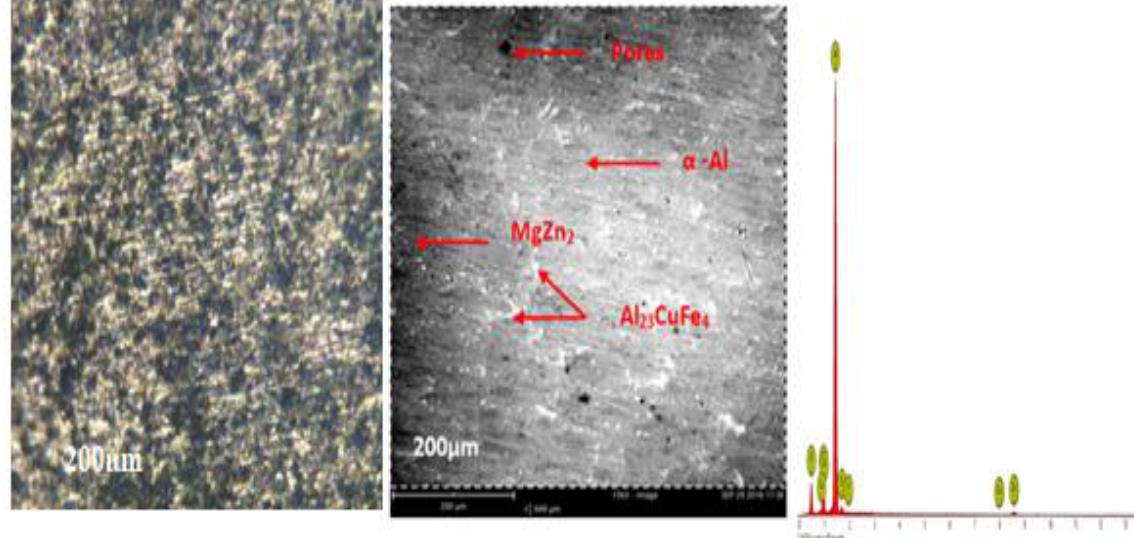
Fig. 4. Optical micrograph, SEM and EDS of Al 5 wt.% Zn at